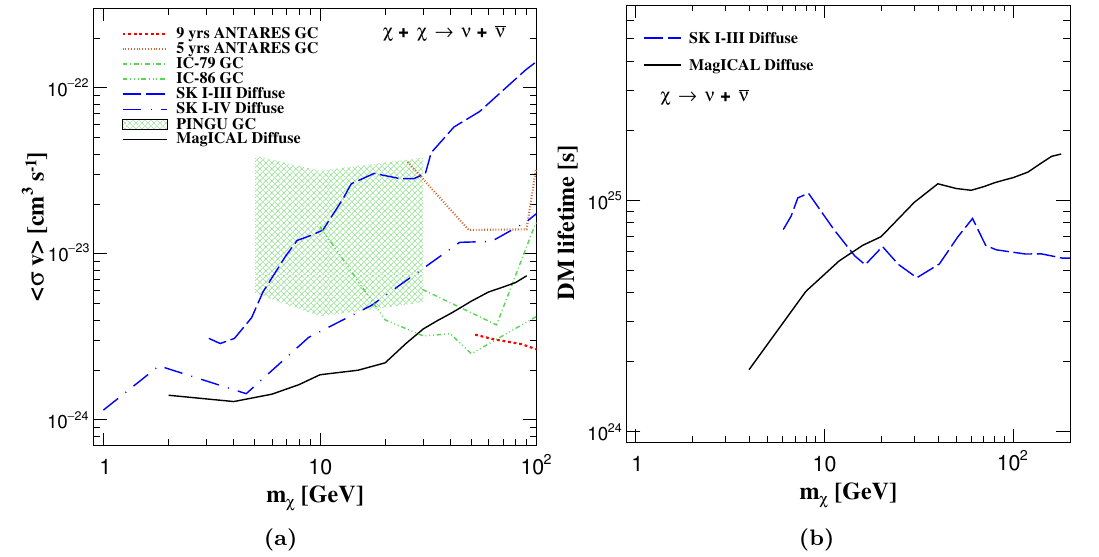
Figure 8. (a) Current bounds at 90% C.L. (1 d.o.f.) on self-annihilation cross-section which are obtained from the (cid:12)rst three phases of Super-Kamiokande [21] (blue long-dashed line), the four phases of Super-Kamiokande [104] (blue long-dash-dotted line), IceCube [65, 105] (green dot-dashed and green triple-dot-dashed lines), and ANTARES [106, 107] (red dotted and red dashed lines) are shown. The future sensitivity of PINGU [108] with its 1 year of exposure is shown by green shaded region. We compare these limits with the bound obtained from 500 kt (cid:1) yr MagICAL (black solid line) detector. For all the cases the NFW pro(cid:12)le is used. (b) Blue long-dashed line shows the current bound on decay lifetime of DM from the (cid:12)rst three phases of Super-Kamiokande [21] using the NFW pro(cid:12)le. We compare this limit with the performance of 500 kt (cid:1) yr MagICAL detector (black solid line) using the same NFW